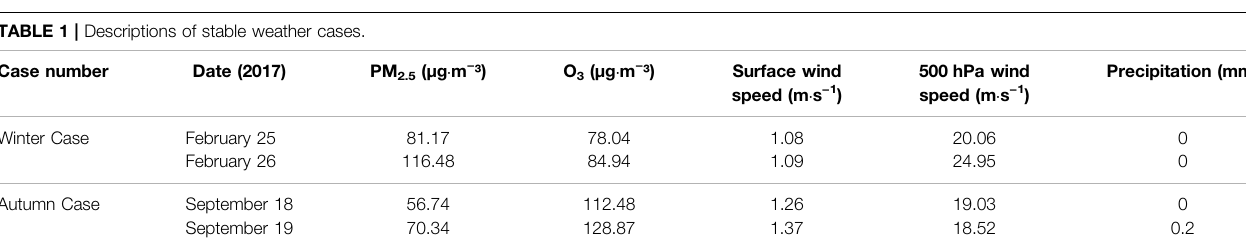
TABLE 1 | Descriptions of stable weather